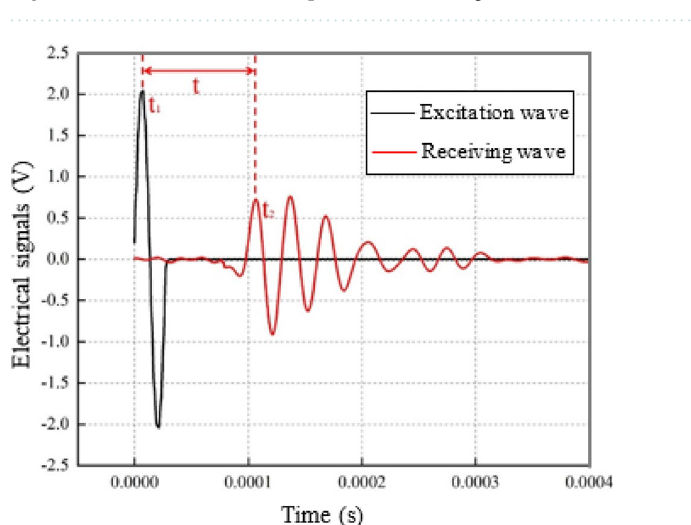
Figure 5. ( a ) P- and ( b ) S-wave speed of the frozen ground as function of depth.